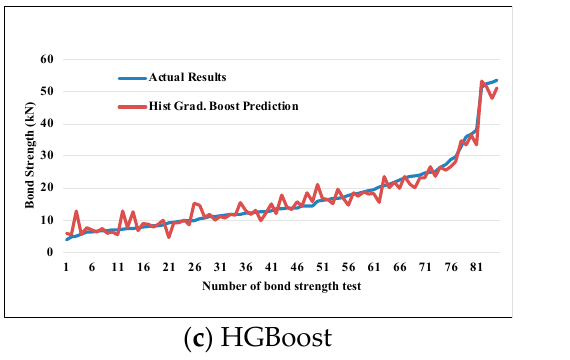
Figure 5. Actual vs. predicted result of the ensemble methods. ( a ) CatBoost, ( b ) XGBoost, ( c ) HGBoost, and ( d ) random forest.